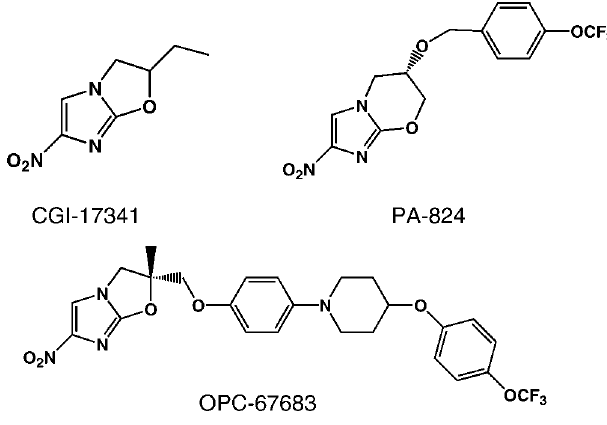
Figure 1. Structure of CGI-17341, PA-824, and OPC-67683 OPC-67683: ( R )-2-methyl-6-nitro-2- f 4-[4-(4-trifluoromethoxyphenoxy)pi- peridin-1-yl]phenoxymethyl g -2,3-dihydroimidazo[2,1- b ]oxazole.